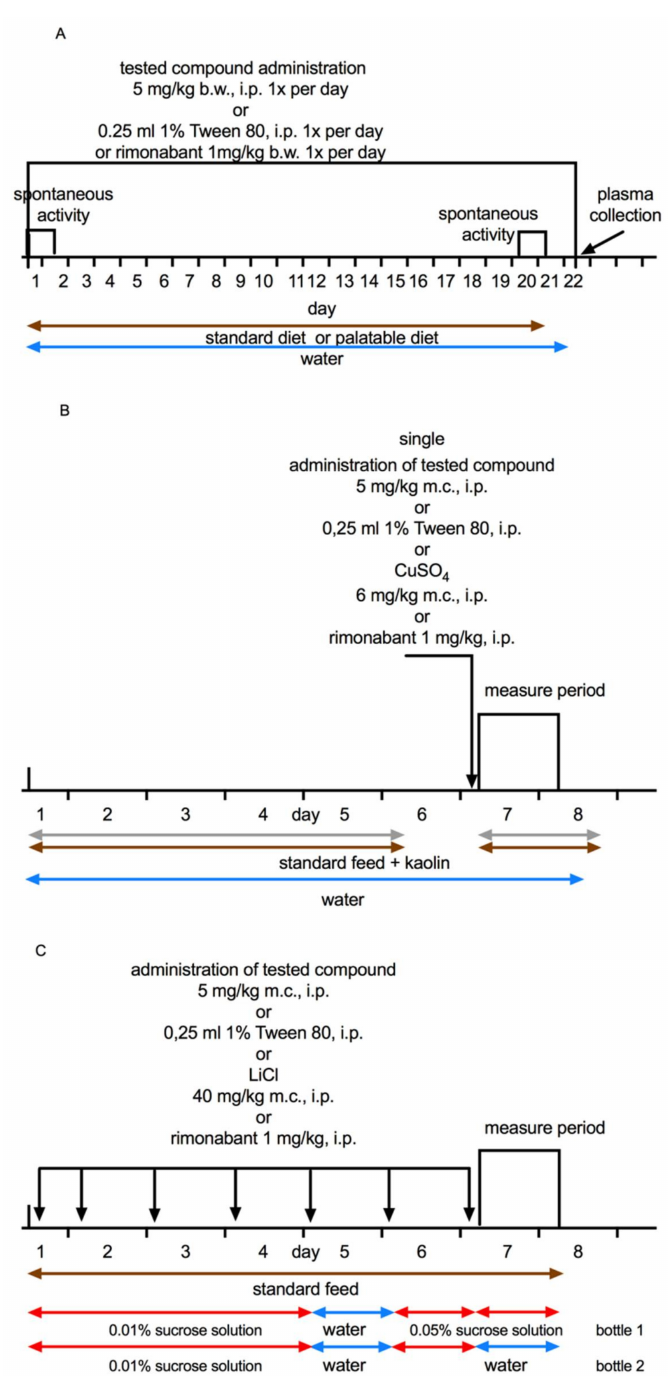
Figure 7. A schematic diagram of chronic administration of tested compounds in model of excessive eating. PSB-KK1415 or PSB-CB27 or PSB-CB5 (5 mg/kg b.w.) or rimonabant (1 mg/kg b.w.) were administrated intraperitoneally (i.p.) to rats for 22 consecutive days. Control groups received 1% Tween 80 ( A ). A schematic diagram of pica behavior test. Rats were treated with single dose of tested compounds (5 mg/kg b.w., i.p.) or rimonabant (1 mg/kg b.w., i.p.). Control group received 1% Tween 80 or CuSO4 (6 mg/kg b.w., i.p.) ( B ). A schematic diagram of conditioned tasted aversion test. Rats were treated with repeated (seven-times) dose of tested compounds (5 mg/kg b.w., i.p.) or rimonabant (1 mg/kg b.w., i.p.). Control group received 1% Tween 80 or LiCl (40 mg/kg b.w., i.p.). The measurement period began on the seventh day of administration and lasted for the next 24 h ( C